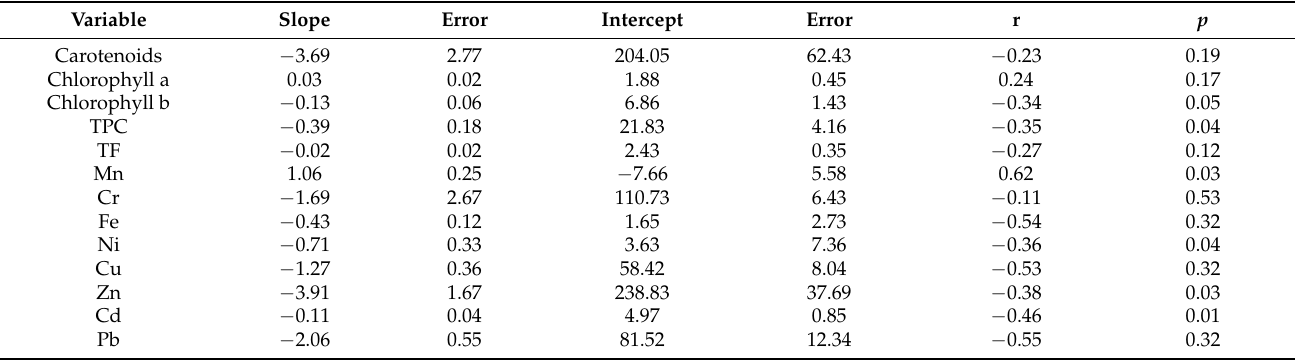
Table 5. Multivariate regression for proline as the dependent variable and biochemical parameters and